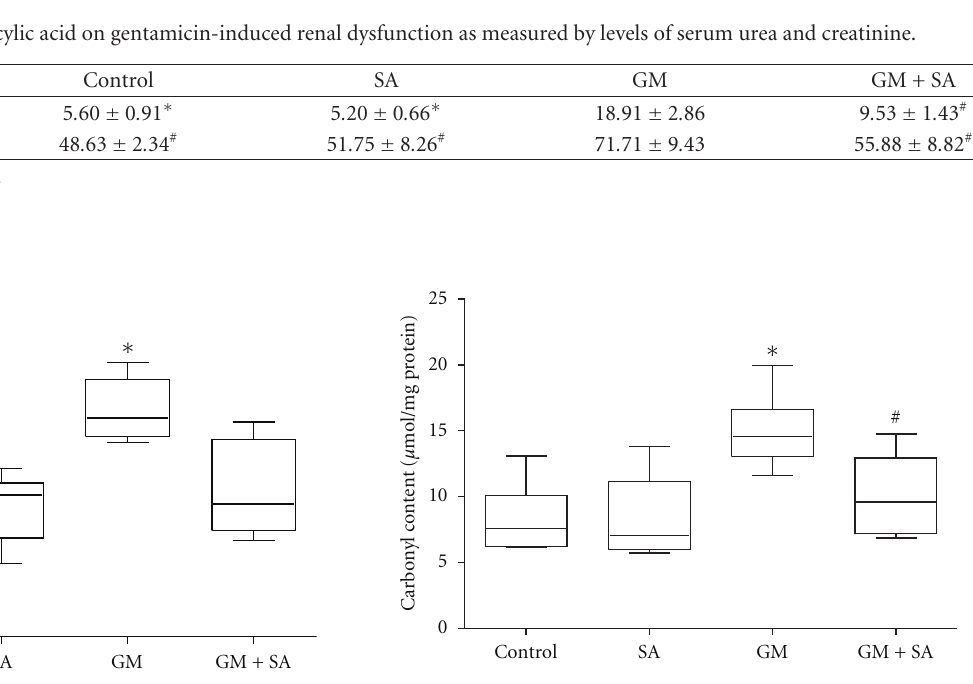
Figure 1: E ff ect of gentamicin (GM), salicylic acid (SA) and their combination on malondialdehyde (MDA) levels in kidney tissues of rats. Values are means ± SD. ∗ P < 0 . 001 versus Control, SA and GM.